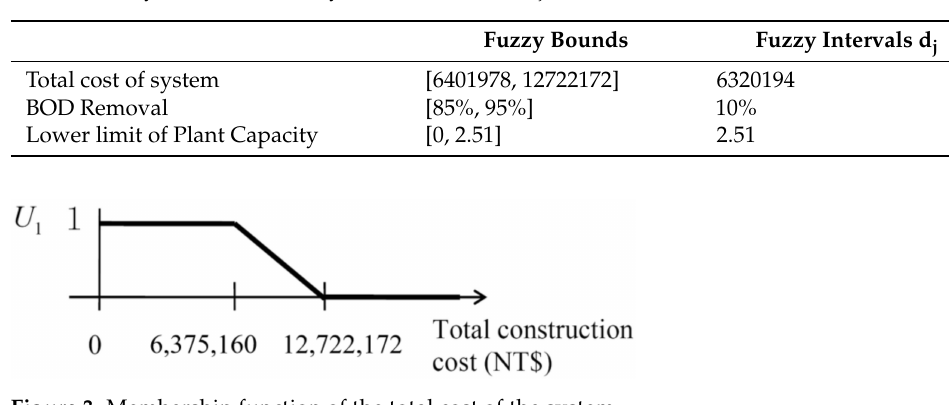
Table 1. Fuzzy bounds and fuzzy intervals of each objective.